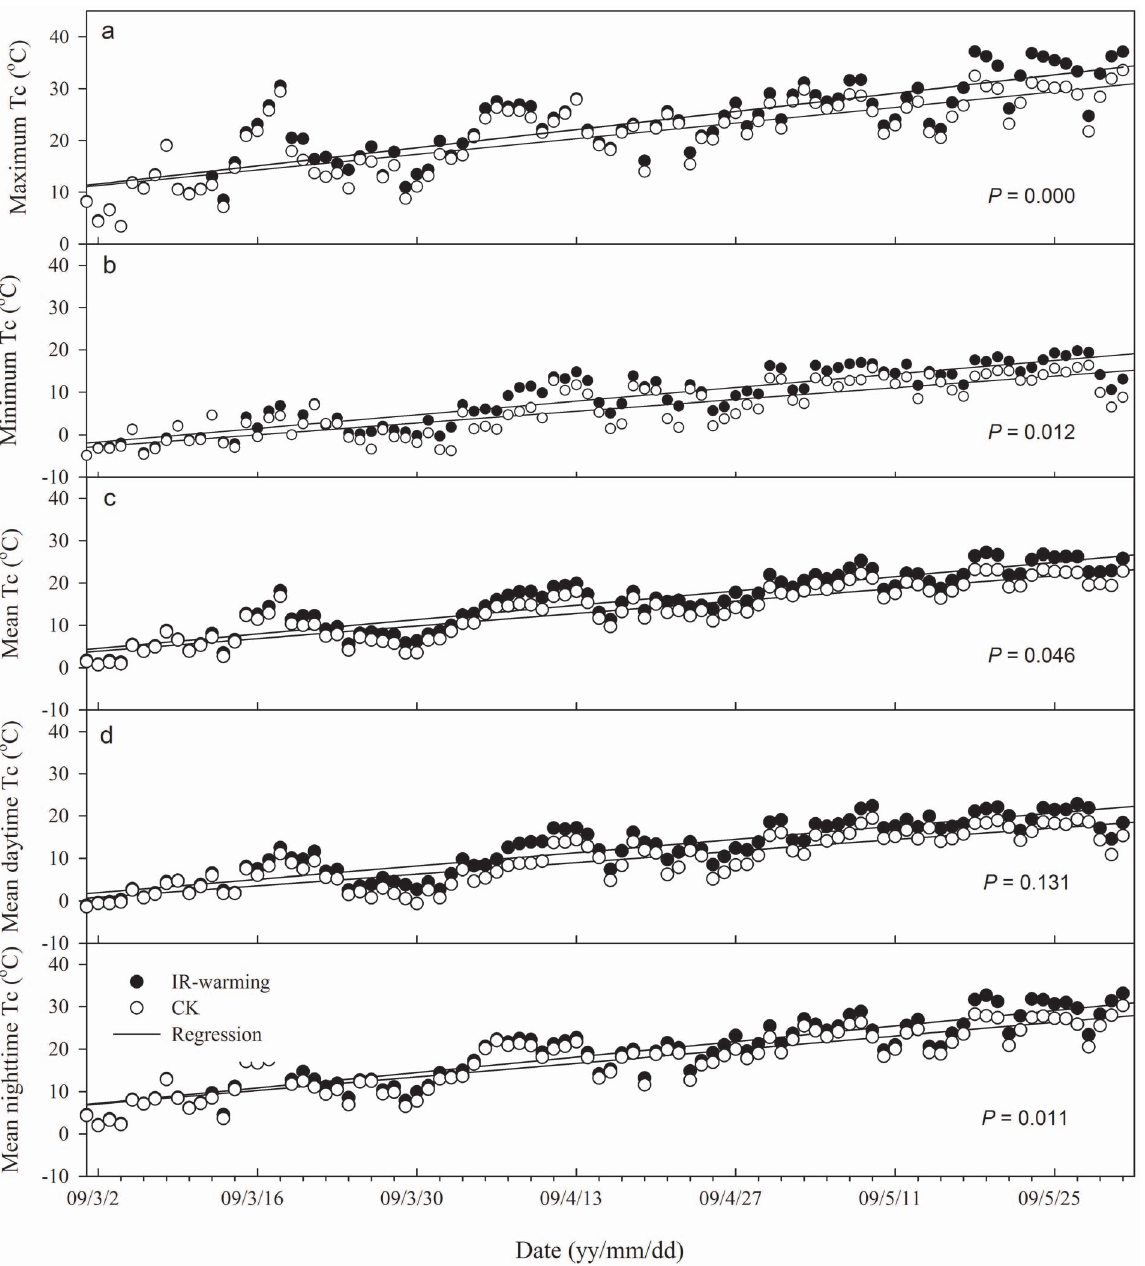
Figure 2. Comparison of winter wheat canopy temperature ( T c ) between IR-warming and control (CK) plots. T c,max , the maximum daily canopy temperature; T c,min , the minimum daily canopy temperature; T c,avr , the average daily canopy temperature; T cd,avr , the average canopy temperature during daytime; T cn,avr , the average canopy temperature during nighttime; P value are used to show significance. P , 0.05 indicated significant difference between